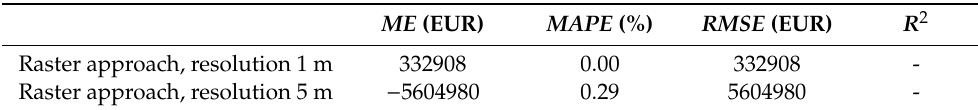
Table 4. Measures of accuracy for the LATIS tool with respect to FLIAT tool for the whole Belgian coast (for N = 1). ME (EUR) MAPE (%) RMSE (EUR) R 2 Raster approach, resolution 1 m 332908 0.00